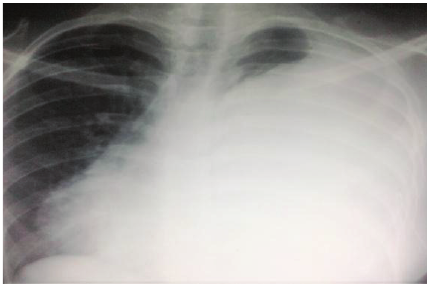
Figure 3: Chest X-ray shows opacity at the lower part of the left hemithorax.